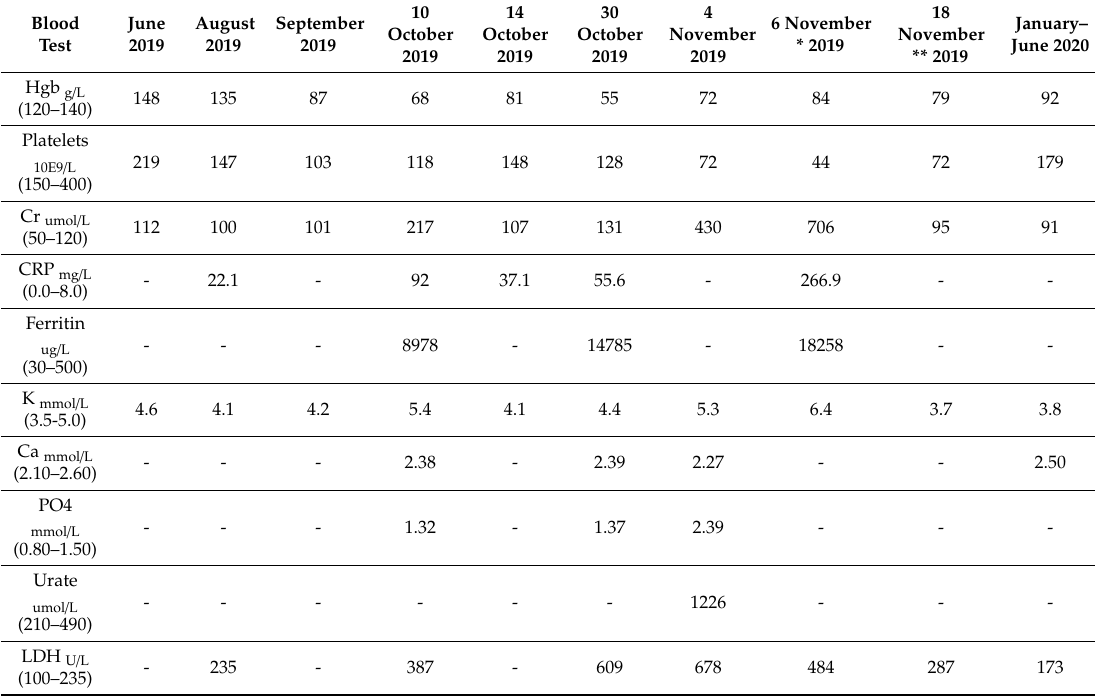
Table 1. Lab values showing a comparison with the values from previous admissions. (-) denotes unavailability of the lab